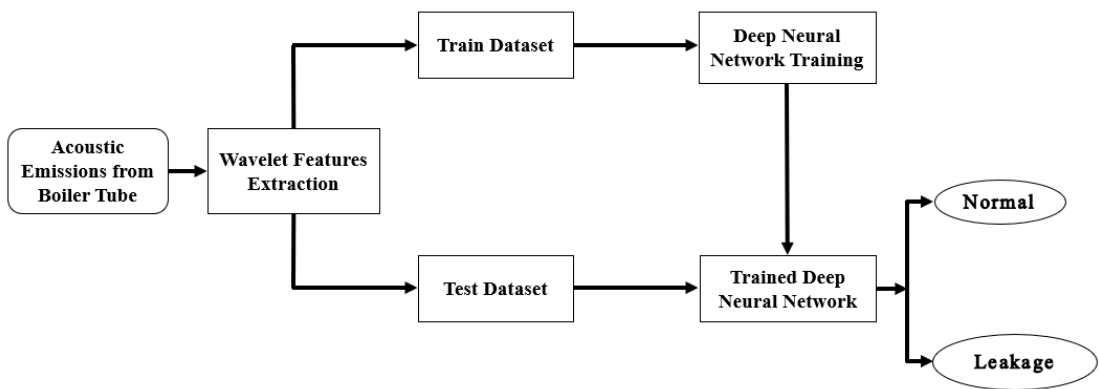
Figure 1. The proposed boiler tube leakage detection model .